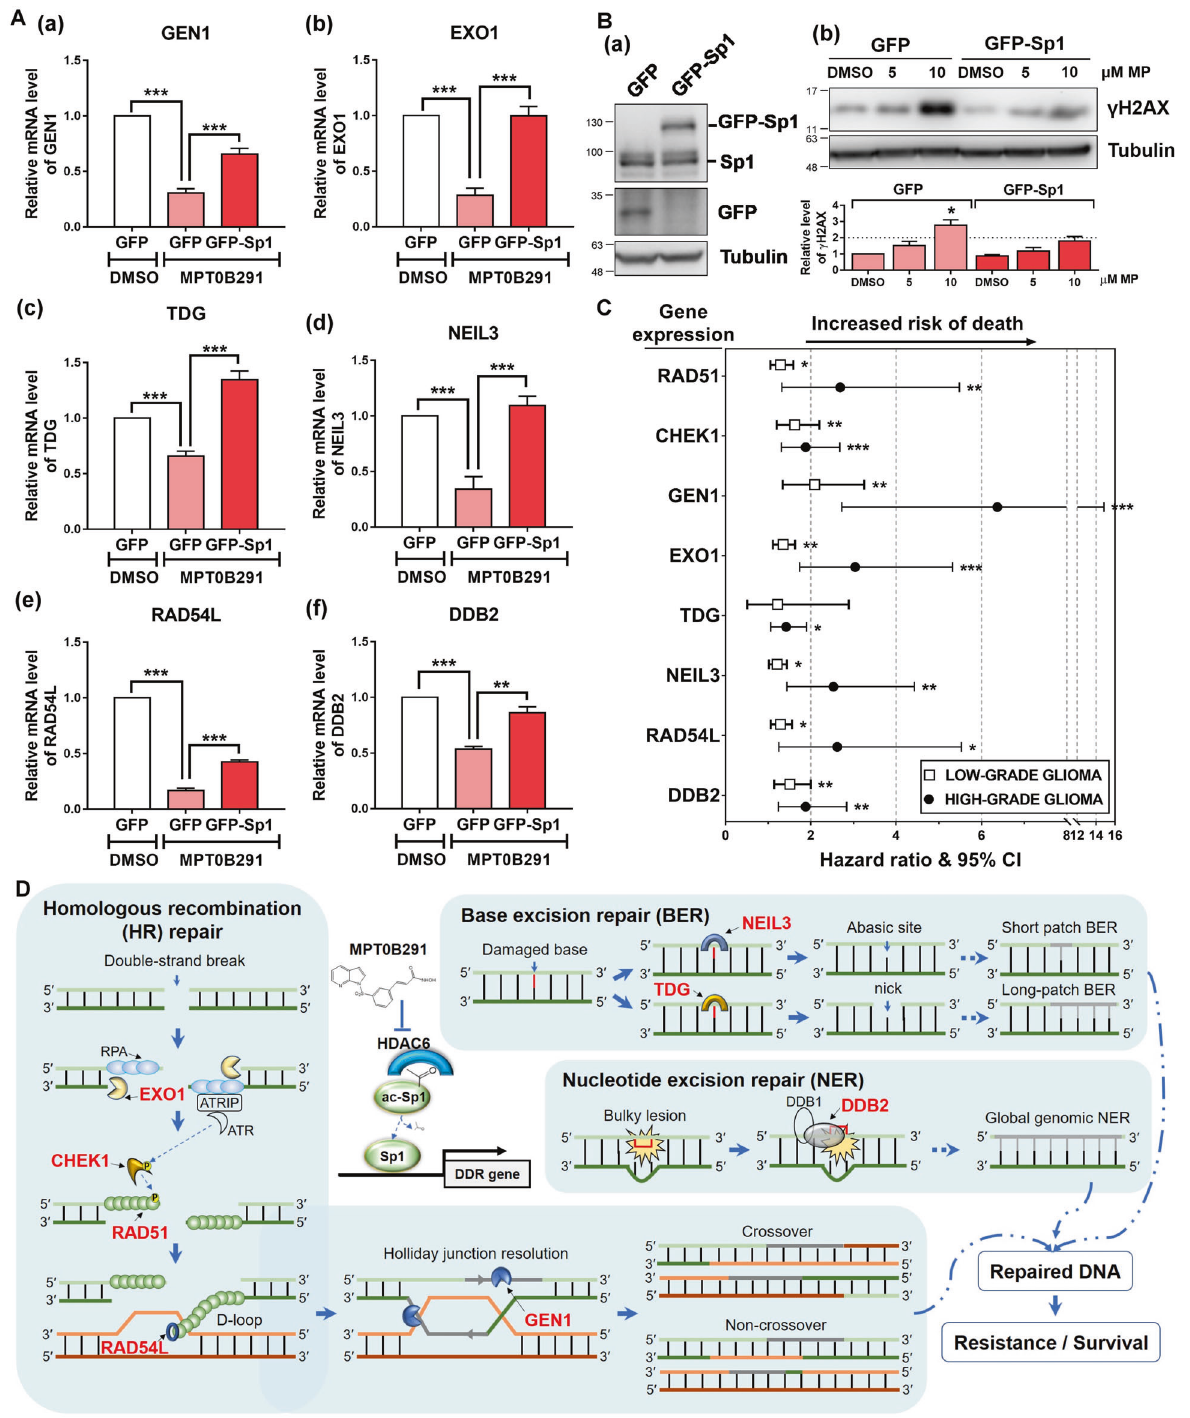
Fig. 6 Sp1 regulates DDR gene expression and impairs MPT0B291-induced DNA damage. A U87MG cells were treated with DMSO or 10 μ M MPT0B291 following transfection with GFP or GFP-Sp1 plasmid. One day after treatment, the mRNA expression of GEN1 (a), EXO1 (b), TDG (c), NEIL3 (d), RAD54L (e), and DDB2 (f) in cells was analyzed by qPCR. Quantitative results (normalized to GAPDH) from fi ve independent experiments are shown. B A172 cells were transfected with GFP or GFP-Sp1, and treated with the indicated dosage of MPT0B291 for 24 h. The protein levels of GFP-Sp1, Sp1, GFP (a), γ H2AX and tubulin (b) were analyzed by western blotting. Quantitative result (normalized to tubulin) of γ H2AX from three independent experiments is shown (lower panel). C Forest plots showing hazard ratios for the risk of death in patients with low-grade and high-grade glioma having higher expression of the indicated gene(s). The lines on both sides denote 95% con fi dence intervals. All the original data (Kaplan – Meier curve) were obtained from PROGgeneV2 database [51] (Supplementary Fig. S6). Hazard ratios above one indicate a poor outcome. D Schematic diagram shows that MPT0B291 induces DNA damage and cell death through the HDAC6/Sp1-mediated DDR gene regulation.